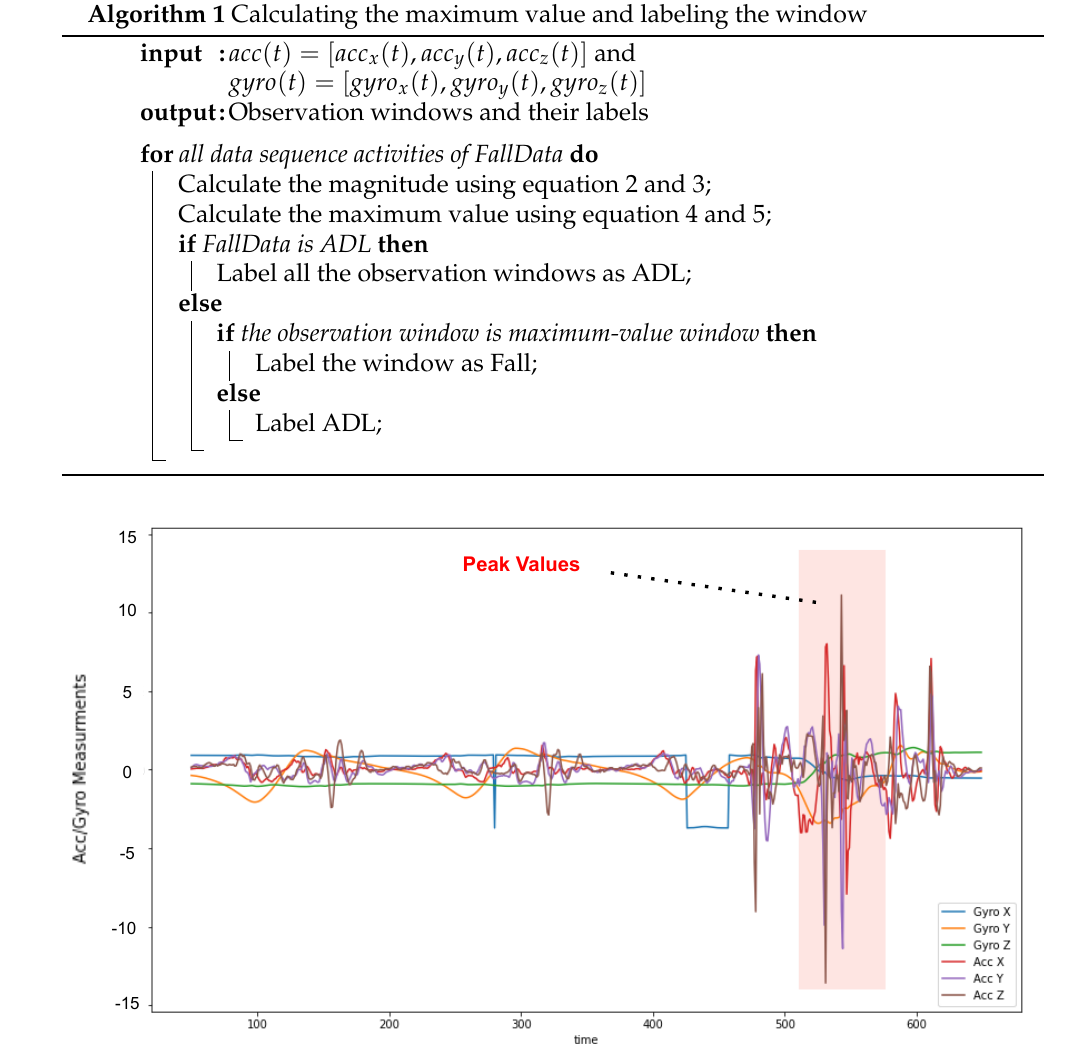
Figure 1. Sliding-window feature engineering based on the maximum signal (peak